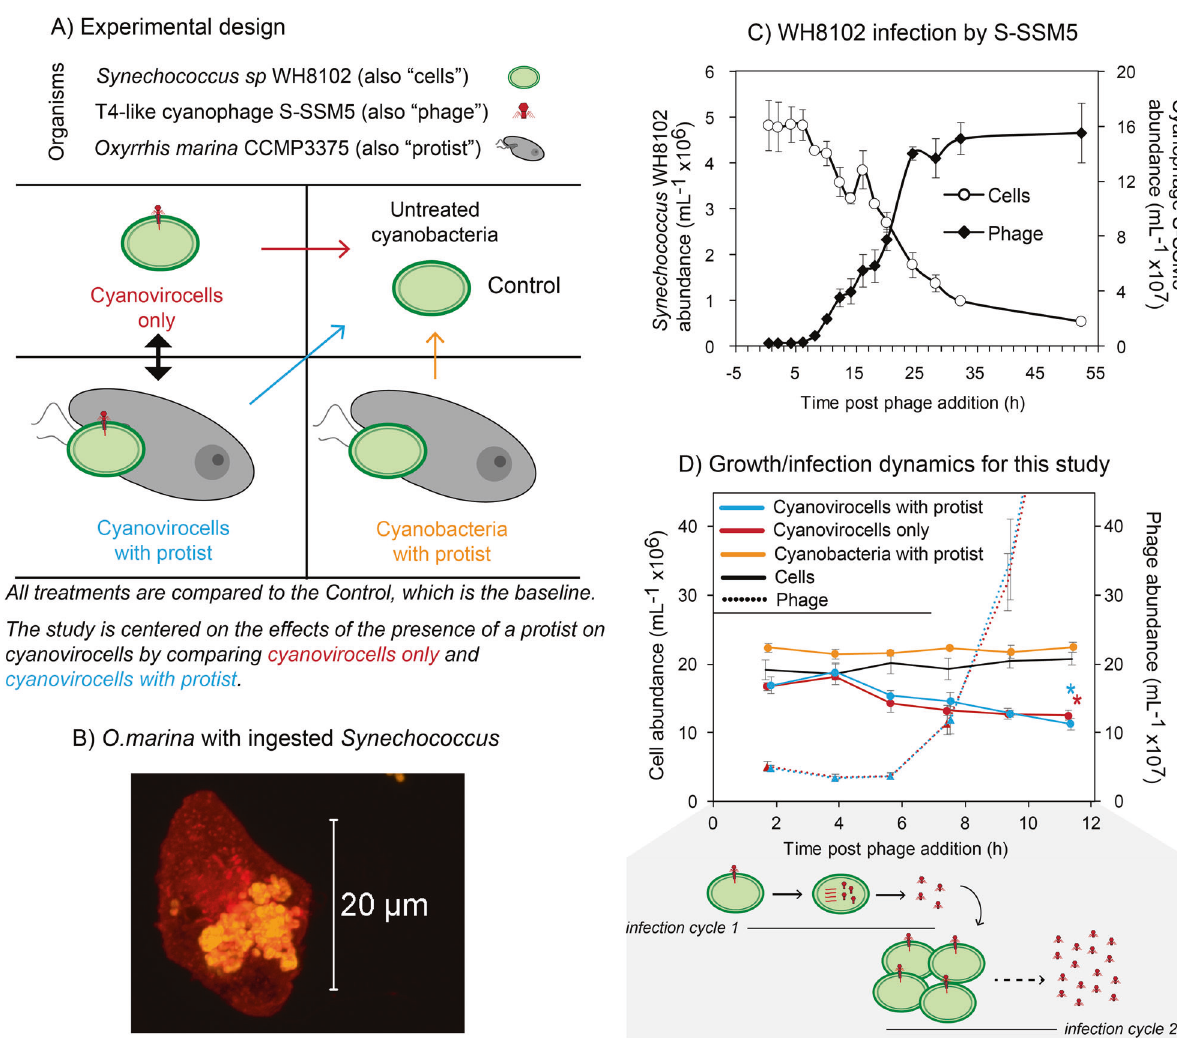
Fig. 1 Experimental design and impacts of a protist on cyanobacteria and cyanobacteria virocells (cyanovirocells). A Experimental design. Synechococcus WH8102 cells were infected with the T4-like myophage S-SSM5 to generate cyanovirocells. Cyanovirocells were studied over the course of infection either alone ( “ Cyanovirocells only ” treatment) or in the presence of the protist Oxyrrhis marina ( “ Cyanovirocells with protist ” ). Arrows denote the comparisons: all treatments are compared against the Control to detect signi fi cant changes to the transcripts, metabolites, and photosynthetic ef fi ciency. In addition, the focus of this study is the cyanovirocell responses to the presence of a protist, which is the contrast between cyanovirocells only and cyanovirocells with protist. B Fluorescent microscopic image of O. marina with ingested Synechococcus cells (protists were stained red with WGA - Alexa 488 and Synechococcus were detected with phycoerythrin pigment auto fl uorescence). Image was acquired using Zeiss LSM 710 confocal microscope with a 63× (1.4 N.A.) objective. C General infection dynamics of Synechococcus infected with S-SSM5, followed over 55 h post phage addition. This time course captures multiple cycles of infection. D Cell and phage abundances over the course of this study. Samples for genome-wide transcriptomics, endo-metabolomics, exo-metabolomics, and microscopy and photosynthetic ef fi ciency measurements were taken every 2 h between 2 and 12 h post phage and/or protist addition. This time course captures a population-level view of infection, whereby more than one infection cycle is taking place (shaded in gray): the phages released from “ infection cycle 1 ” infect new cells and undergo “ infection cycle 2 + ” (i.e., two or more asynchronized infection cycles may be happening at this time). Both the burst size (here depicted as 4 phages released per infected cell), and the number of infection cycles are simpli fi ed. Cell abundance decreases signi fi cantly from start to end of ‘ omics sampling during phage infection ( t -test, p value <0.05), with or without protist (indicated by an asterisk for each treatment), and it does not signi fi cantly change in the presence of the protist alone. All experiments included a minimum of three biological replicates and the average with standard error is that a larger number of host genes enhanced their expression in 153 genes were over-expressed. the cyanovirocells co-cultured with the protist than without it. In We next examined the functions of these 153 host transcripts addition, when protist was added, the cellular transcriptional that responded at 6 h in the cyanovirocells with protists by response was greater toward the end of the infection cycle, as the grouping them into functional categories. The category with the majority (52%, n = 153) of the genes were DE at 6 h post phage most genes was the “ unknown ” (not functionally annotated, addition, compared with only 18% at that same time without the protist (Supplementary Fig. S5B). Thus, when protist was added, the cyanovirocells treated with the protist relative to the host transcriptional responses were greatest toward the end of